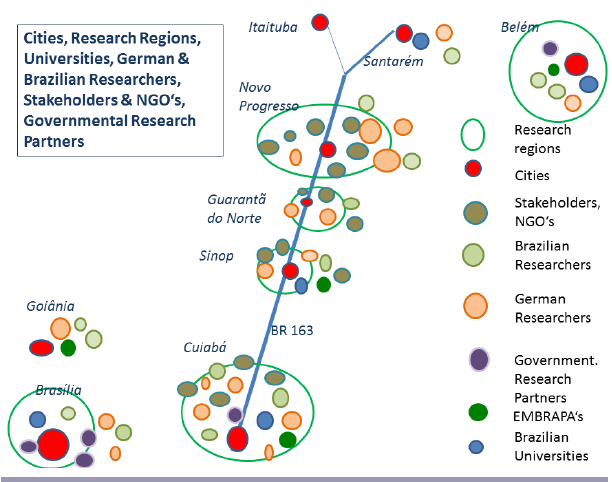
Fig. 1 . Stakeholder and